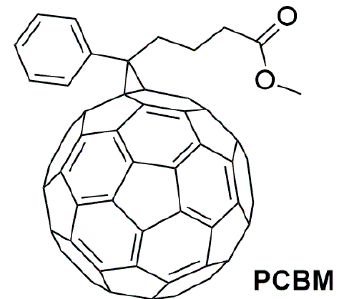
Figure 6a. Chemical structure of phenyl-C61-butyric acid methyl ester (PCBM).